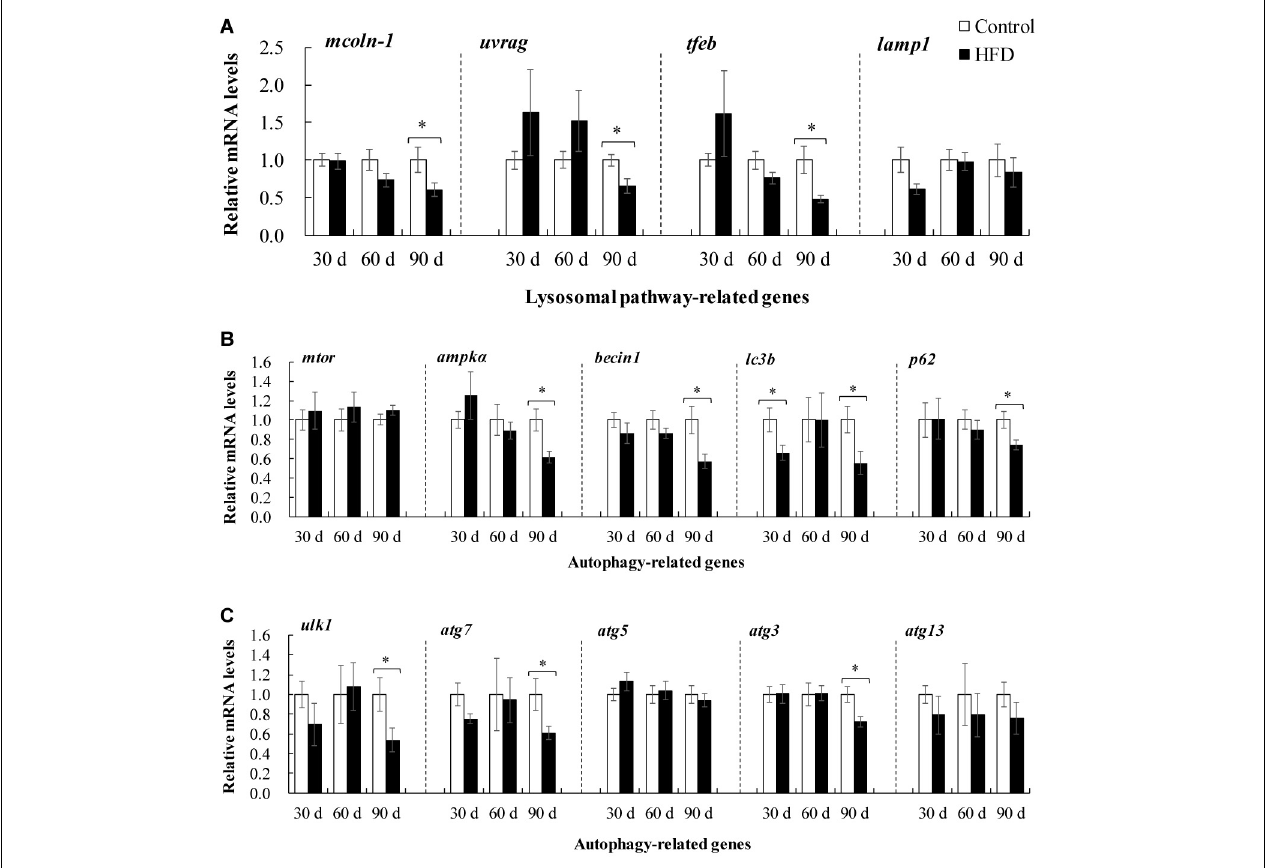
FIGURE 7 | Expression of autophagy-related genes in liver of tilapia fed on control diet and HFD for 90 days. (A) Expression of lysosomal pathway-related genes including mcoln-1 , uvrag , tfeb , and lamp1 ; (B,C) expression of autophagy-related genes mTOR, ampk α , becin1 , lc3b , p62 , ulk1 , atg7 , atg5 , atg3 and atg13 . The values are normalized to control values and expressed as means ± SEM ( n = 10); ∗ P < 0.05 versus control at same time.